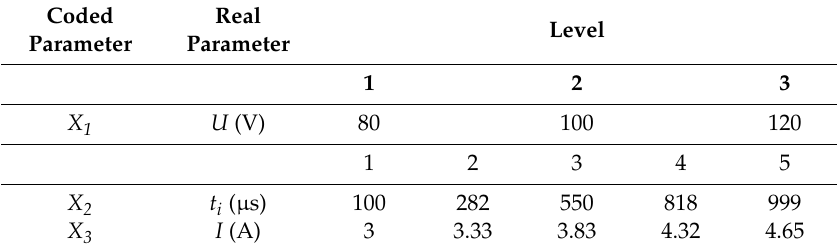
Table 4. Process parameters and their levels.